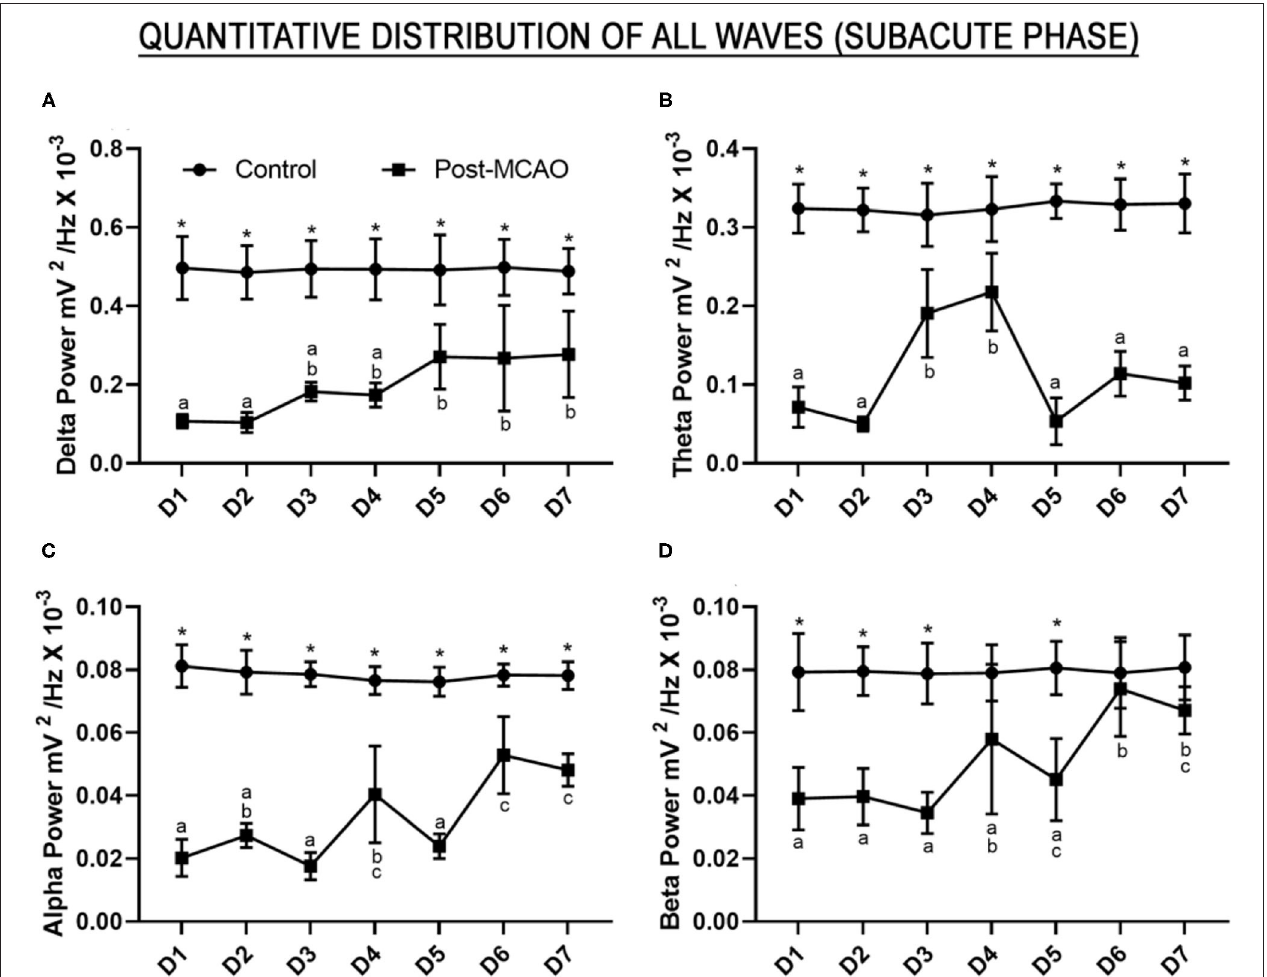
FIGURE 3 | Relative bandpower of all the brainwaves (1–28Hz) of the post-ischemic animals monitored for 7 days. (A) Quantitative electroencephalographic data on the relative delta wave bandpower; (B) Relative theta wave bandpower; (C) Relative alpha wave bandpower; (D) Relative beta wave bandpower. The data are expressed as means ± SD ( n = 6 animals per group); * p < 0.05: control vs. post-MCAO group. Different letters above the data points denote significant differences between days ( p <